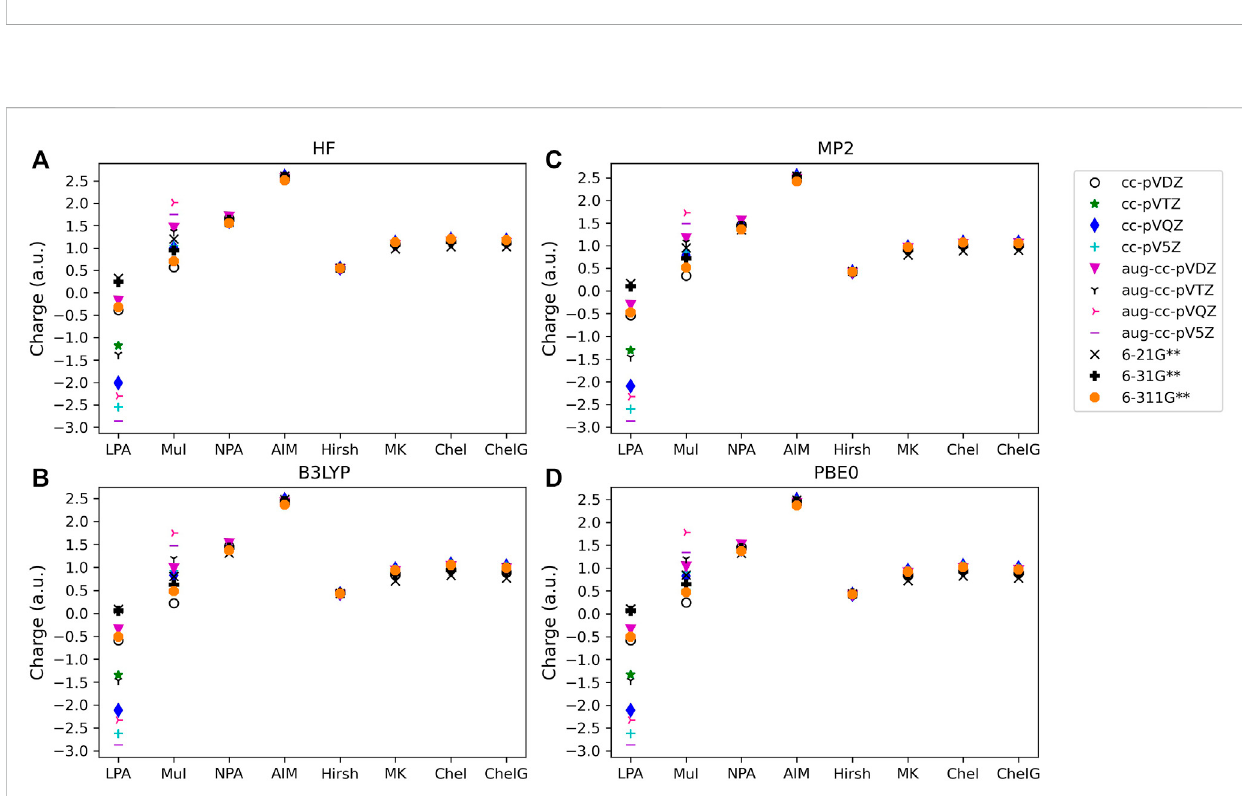
FIGURE 3 Atomic charge determined for noted basis set, analysis method and quantum mechanical method: (A) HF, (B) B3LYP, (C) MP2, and (D) PBE0 for one of the triatomic compounds investigated, BF 3 . Charges for the two remaining polyatomic compounds are included in the SI.